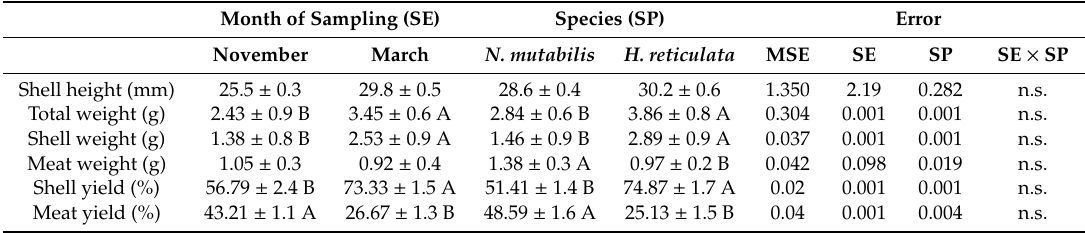
Table 1. Mean values of shell height, total weight, shell weight and meat weight of the two species of sea snails according to month of sampling (SE) and species (SP).